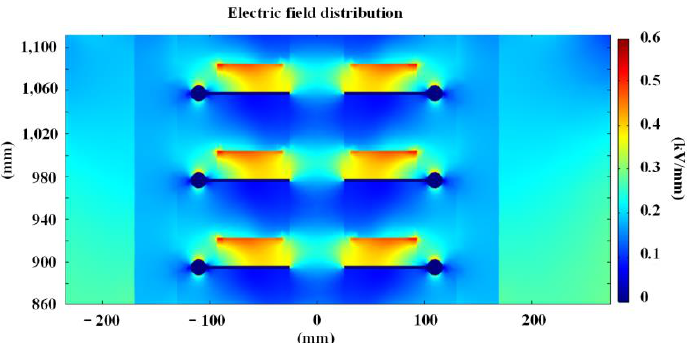
Figure 5. Electric field distribution at the edges of the shielding electrodes.